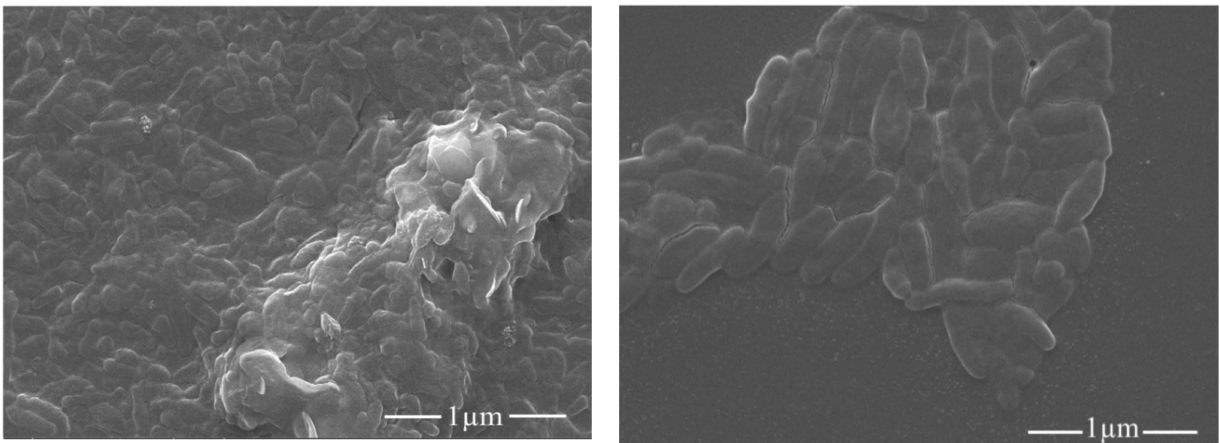
Figure 10. SEM images of pristine and AGO